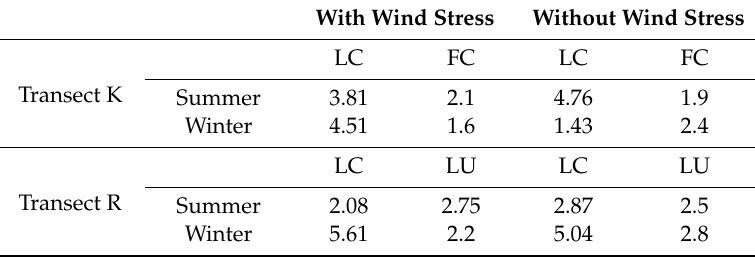
Table 2. Volume transport of the Leeuwin current, Leeuwin undercurrent and Flinders current in summer and winter across transects R (Capes region) and K (Albany), with and without wind stress (units: